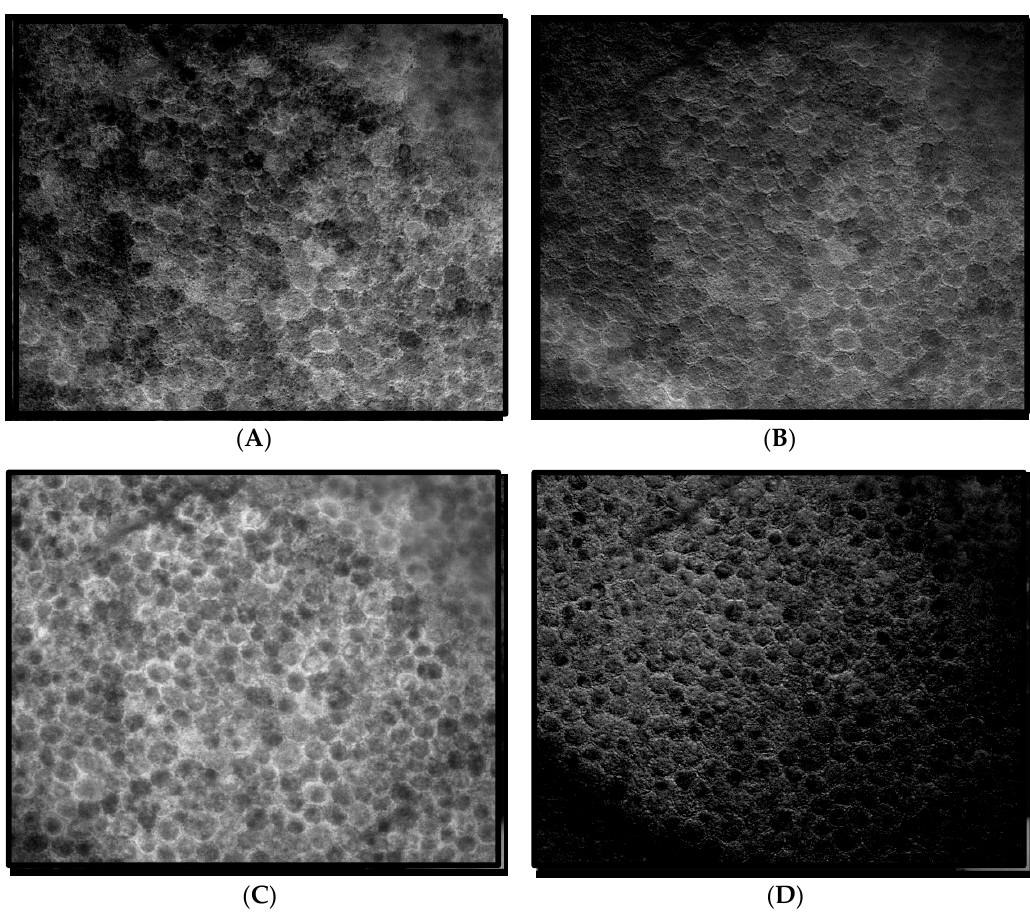
Figure 2. Comparison of abundance maps in an image with soft drusen achieved with two and three wavelengths of excitation. In these abundance maps, the brightness at each point is proportional to the strength of the emission of the given spectrum at that point. ( A , C ) Abundance maps achieved with two excitation wavelengths (436 nm and 480 nm, adapted from [14]). ( B , D ) Abundance maps achieved with three excitation wavelengths (436, 480 nm, and 505 nm). ( A , B ) Abundance maps of the retinal pigment epithelium (RPE) fluorophore spectrum S3 ( A ) and S2 ( B ). Note the high abundance of the RPE fluorophore source surrounding the dark nuclei in each cell. The distribution of fluorophore on the right may suggest attenuated RPE overlying the drusen. ( C , D ) Abundance maps of the drusen spectrum (SDr). The increased detail in the abundances of both RPE fluorophores and SDr obtained by going from two excitations (left) to three (right), is evident. More information is needed to discern among localizations in the Z ‐ axis of this projection image.